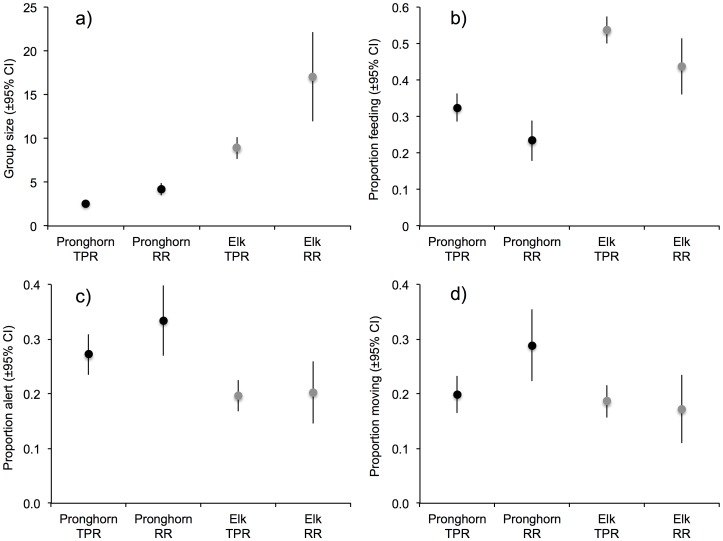
Comparisons of the average group size (a), and proportion of pronghorn and elk engaged in feeding (b), alert behavior (c) and movement (d) at the Teton Park Road and the River Road. Data are presented as means ±95% CI.